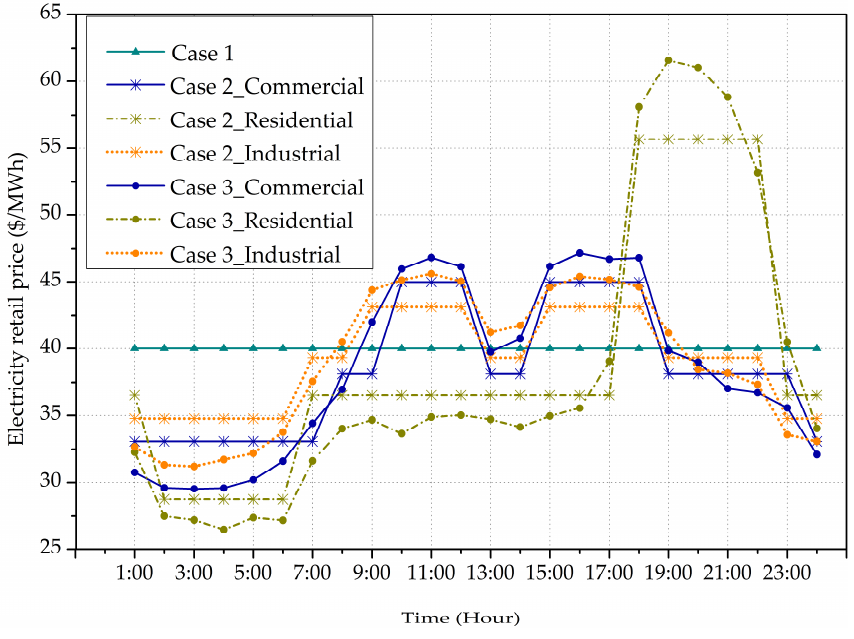
Figure 3. Electricity retail prices for customers.